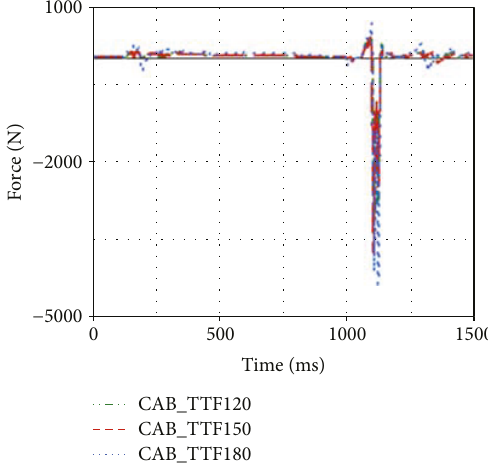
Figure 15: Upper neck F